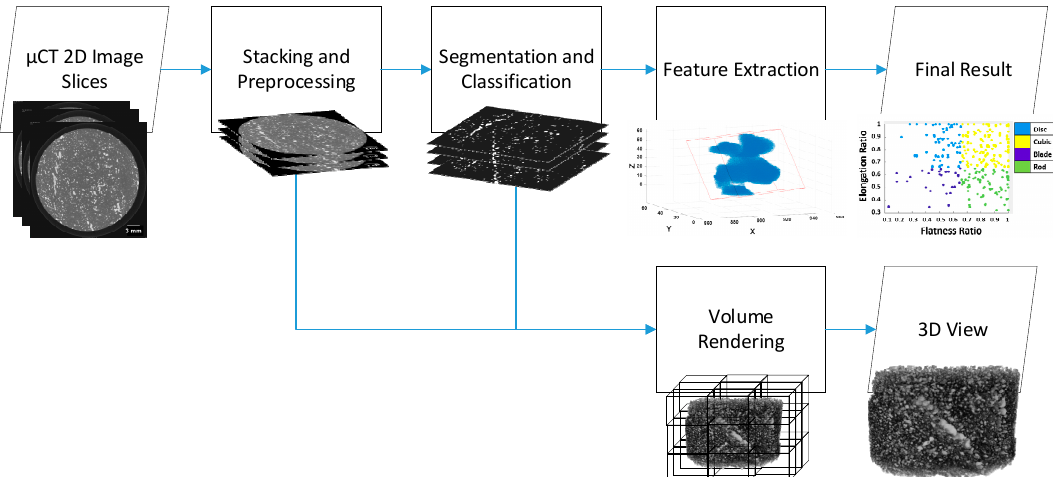
Figure 1. Typical workflow involved in µ CT data analysis for mineral characterization. The resulting 2D µ CT slices are stacked and preprocessed into a 3D image. Segmentation and classification are performed so that a volume of interest (VOI) can be analyzed further. In relation to mineral characterization, this VOI usually represents a phase in the sample (an example here is the sulphide phase), so that features of that phase can be extracted (an example here is the grain shape). Volume rendering is done to produce a 3D view on a 2D display screen.